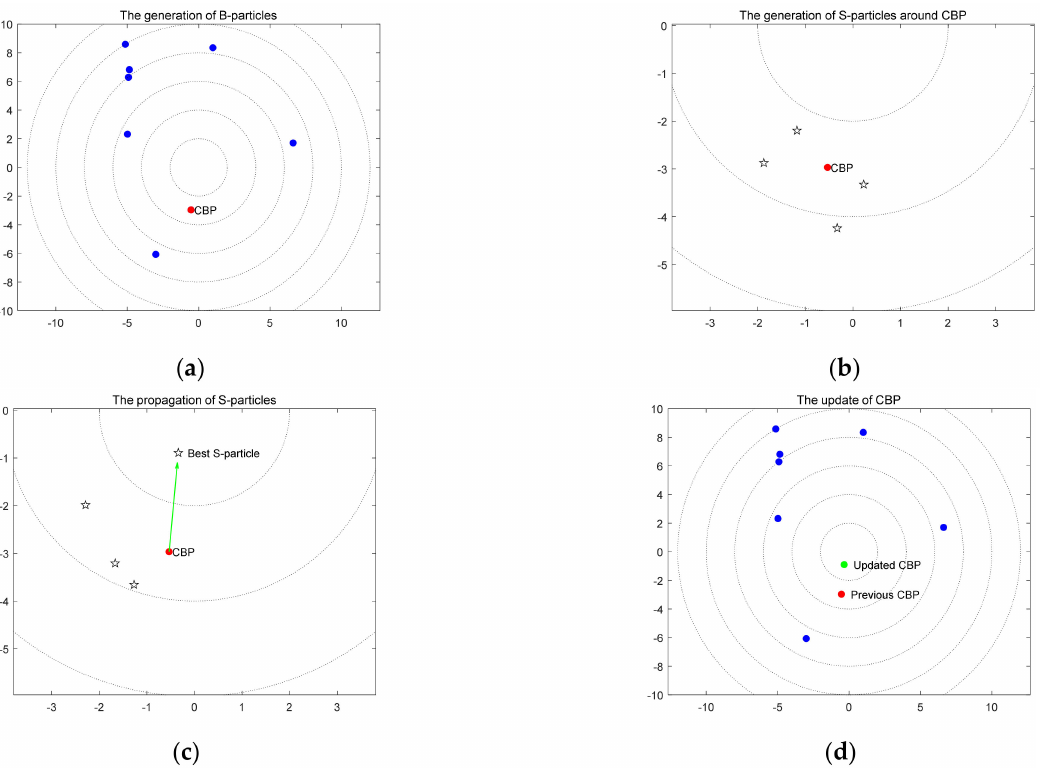
Figure 2. Update process of CBP in